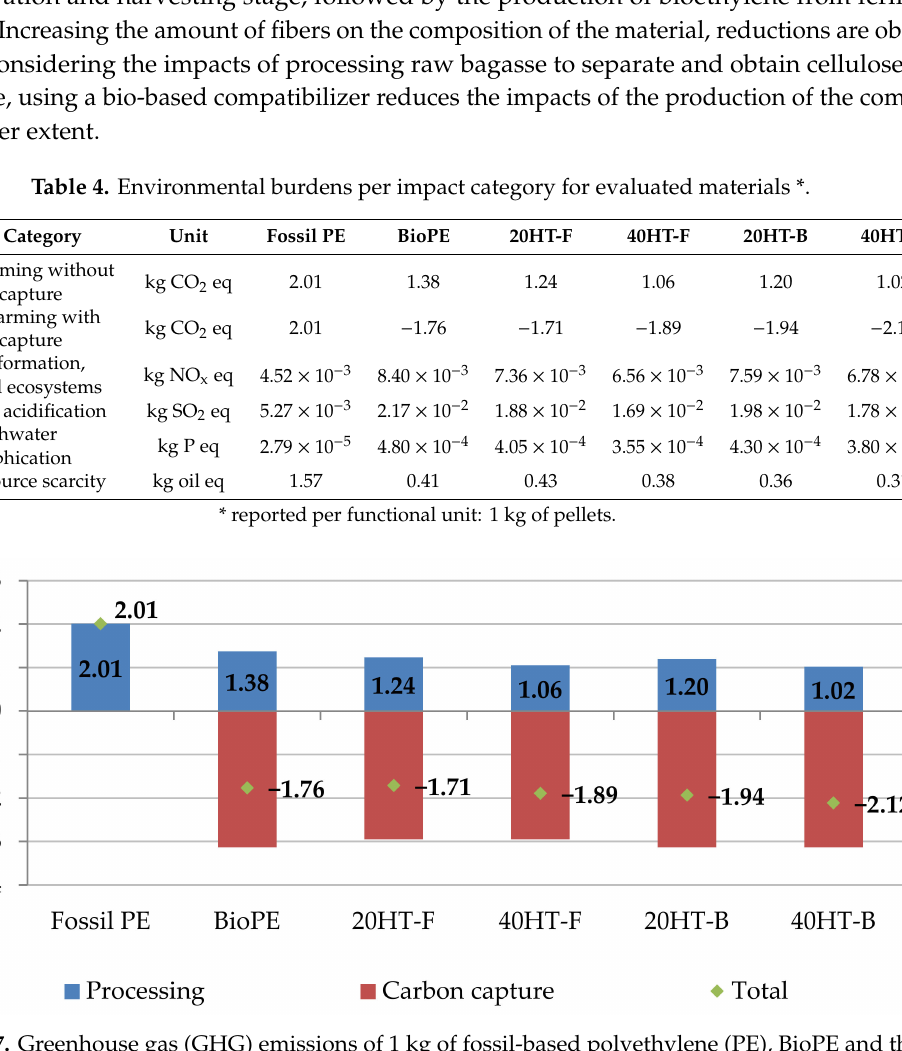
Figure 7. Greenhouse gas (GHG) emissions of 1 kg of fossil-based polyethylene (PE), BioPE and the corresponding biocomposites, from a cradle-to-gate perspective.